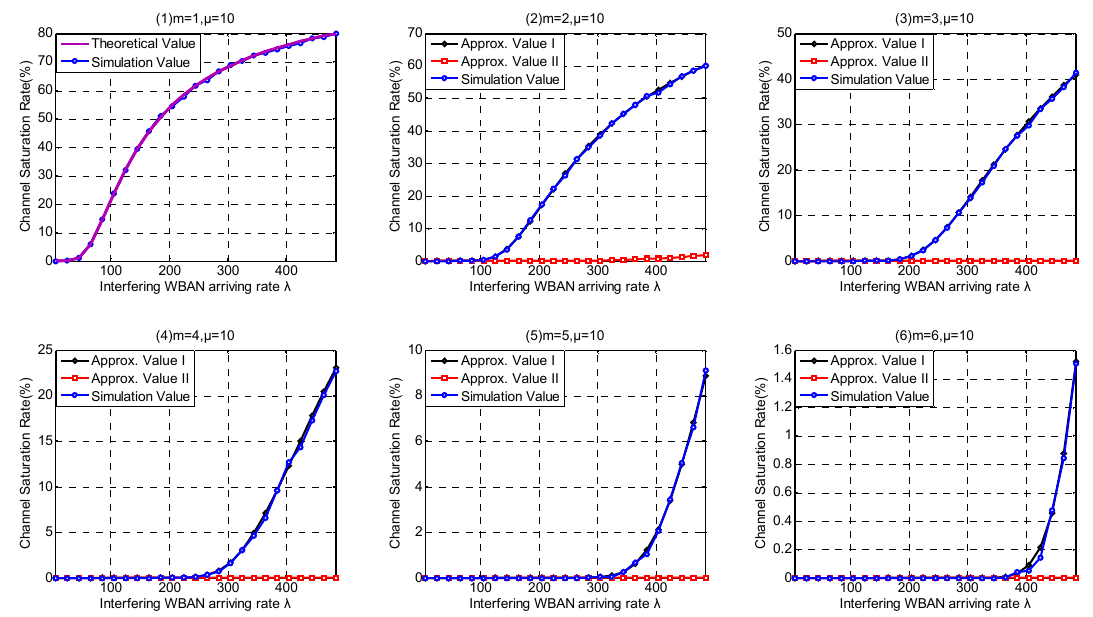
Figure 20. Channel Saturation Rate in Service-independent coexisting WBANs.